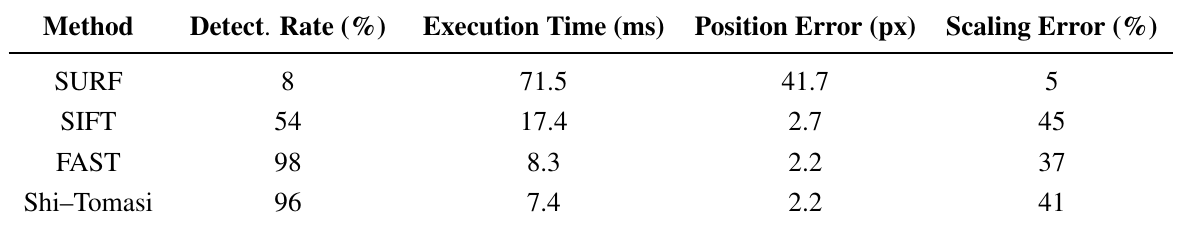
Table 1. Performance evaluation of the feature detectors for target